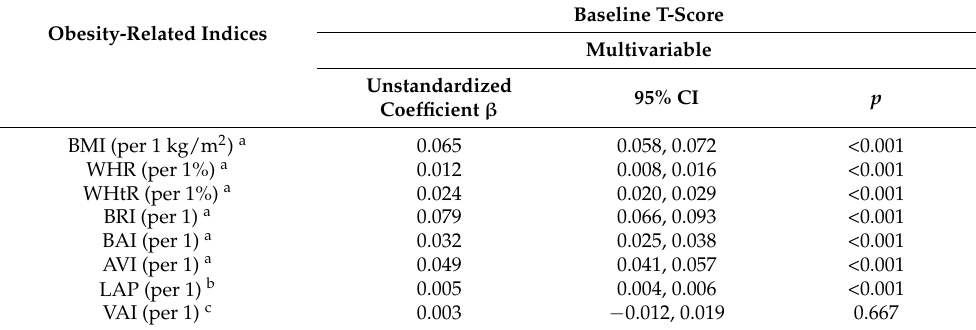
Table 4. Determinants of baseline T-score using multivariable linear regression analysis. Obesity-Related